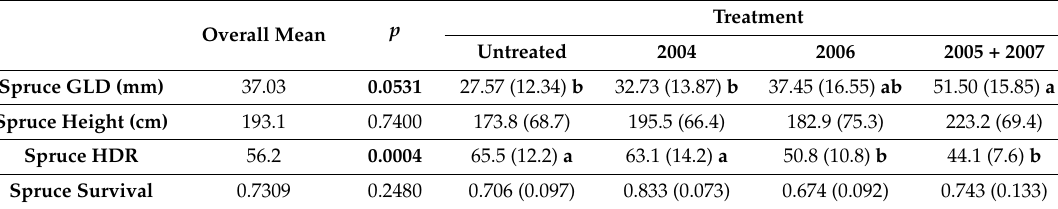
Table 8. Effects of treatments on spruce mean diameter (GLD), height, height:diameter ratio (HDR), and survival. Standard deviation is shown in brackets () beside each mean. Where Analysis of Variance indicates significant treatment effects ( p < 0.10), p values are shown in bold and bold letters are used to indicate differences between treatments determined using Tukey’s HSD test ( p <